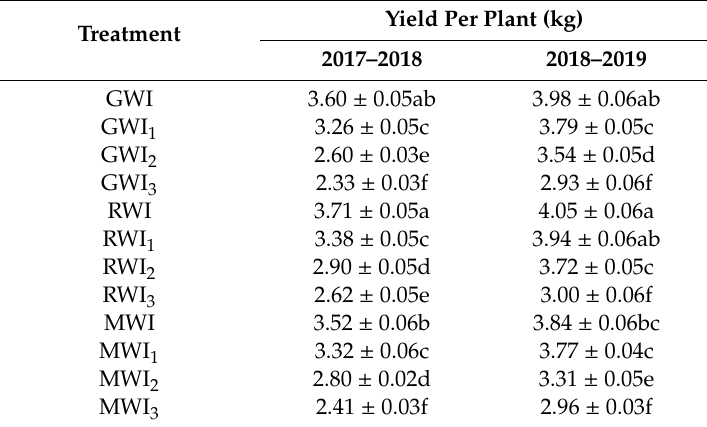
Table 6. Descriptive statistics of yield per plant across three water qualities and four irrigation